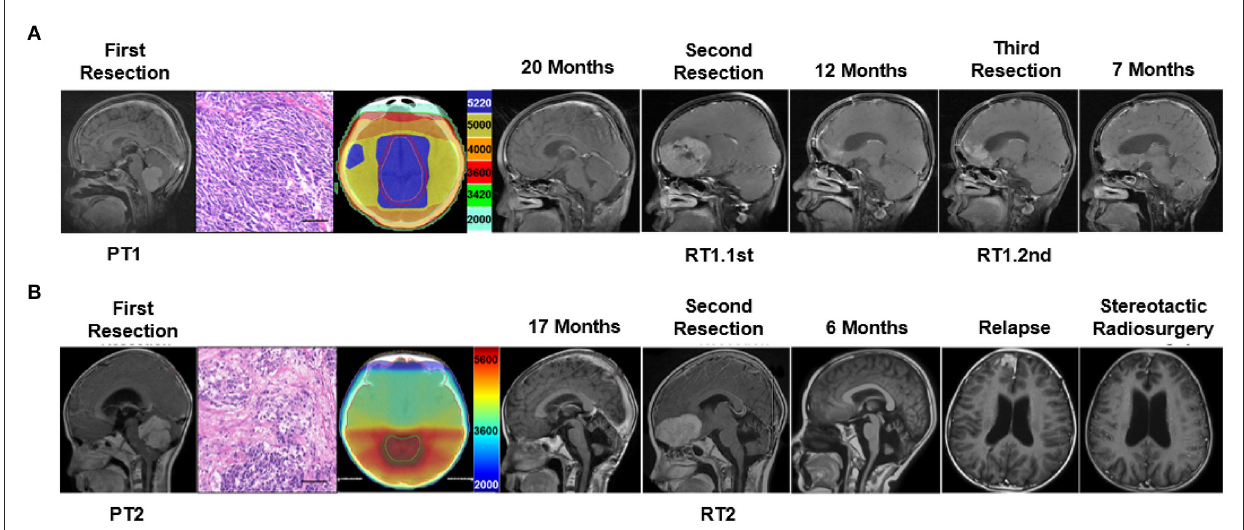
FIGURE1 Clinical characteristic and the treatment flow process of the two cases subjected to tumor molecular profiling. (A) Delineation of radiotherapy target and MRI imaging of treatment process of case 1 and (B) case 2. Scale bar = 50 µ